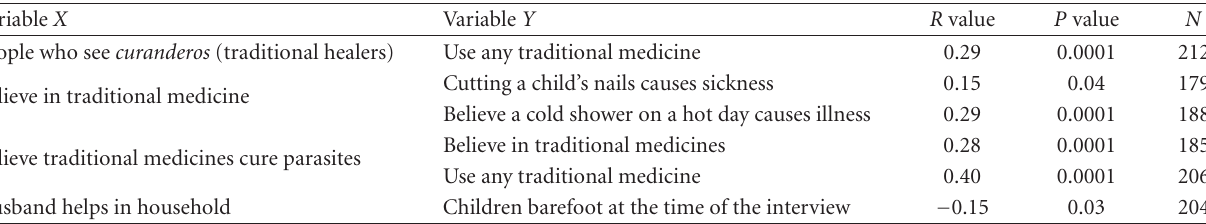
Table 6: Correlations among cultural variables ∗